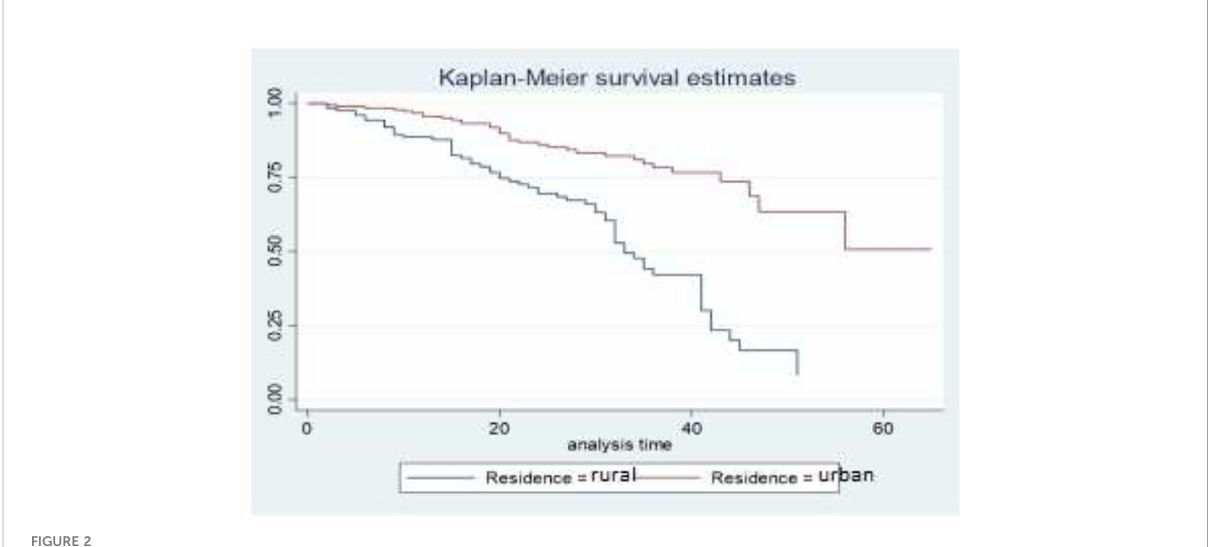
FIGURE 2 Survival curves by